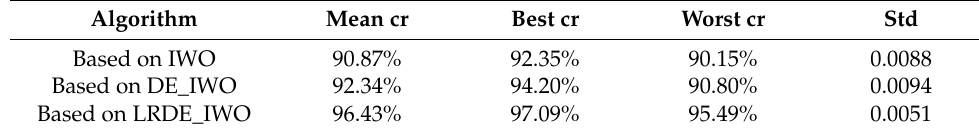
Table 4. Comparison of the results in the 100 m × 100 m area and 80 nodes.